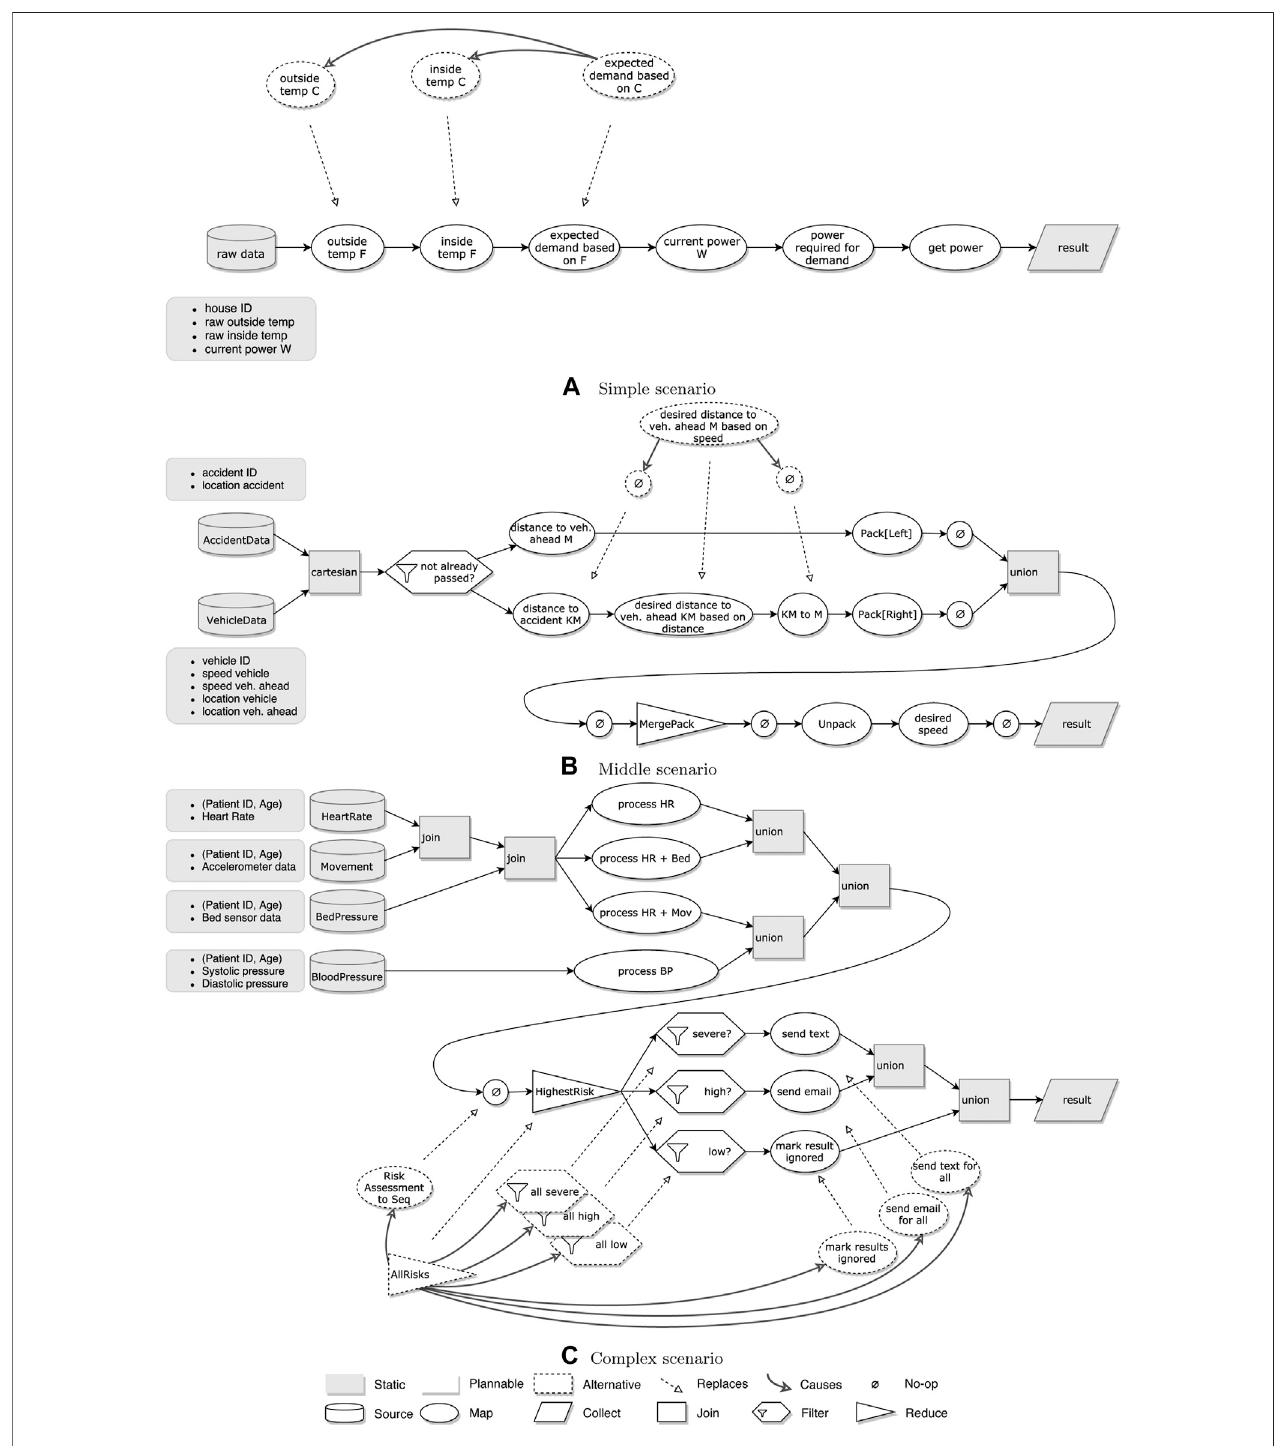
FIGURE 7 | Pipelines for three different scenarios: (A) simple, (B) middle, and (C) complex.